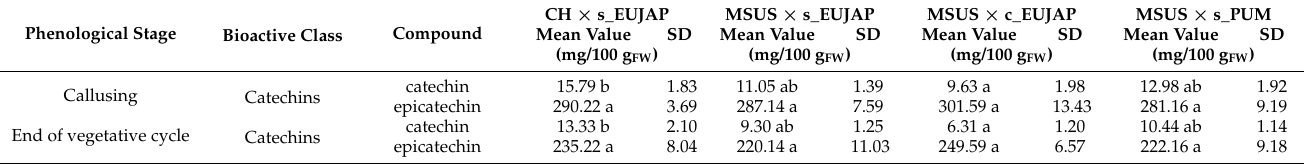
Table 4. Catechin fingerprint of the tissues at the graft union. The results are reported as mg of bioactive compound per 100 g fresh weight